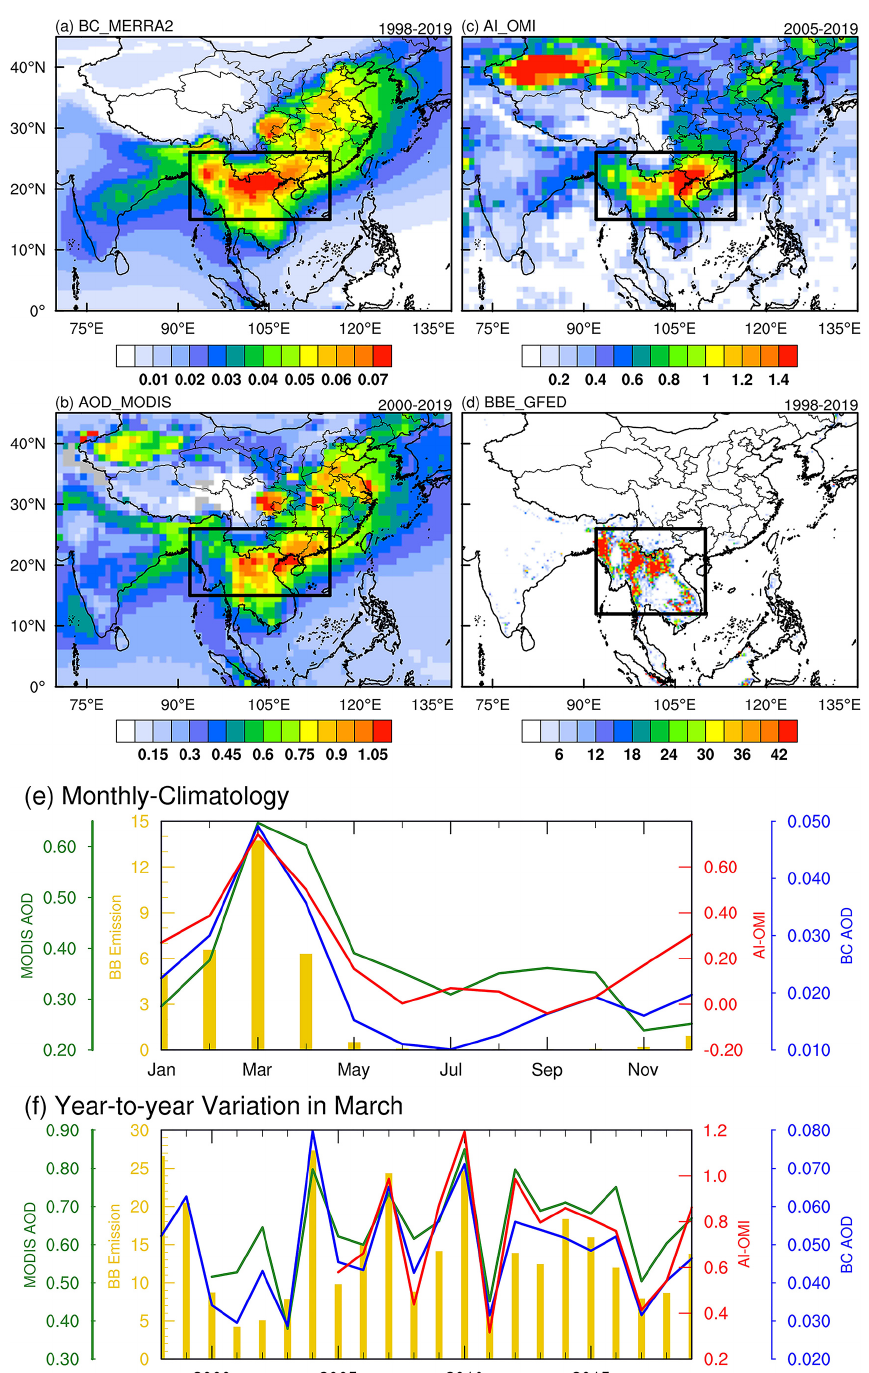
Figure 1. Spatial distribution of March (a) black carbon (BC) aerosol optical depth (AOD; shading, unitless) averaged over 1998–2019 from MERRA-2, (b) AOD (unitless) averaged over 2000–2019 from MODIS Terra, (c) aerosol index (AI; unitless) averaged over 2005–2019 from OMI, and (d) biomass burning (BB) carbon emission (shading; gCm − 2 month − 1 ) averaged over 1998–2019 from GFEDv4.1. (e) Monthly climatology of BB aerosol indices (blue line for BC AOD, green line for AOD, red line for AI) and emission (gold bar) averaged over Indochina (92–115 ◦ E, 15–26 ◦ N for BC AOD, AOD, and AI; 92–110 ◦ E, 12–26 ◦ N for BB emission, as outlined by the black boxes in panels a – d ). (f) Same as (e) but for the time series of monthly averaged BB aerosol indices in March.